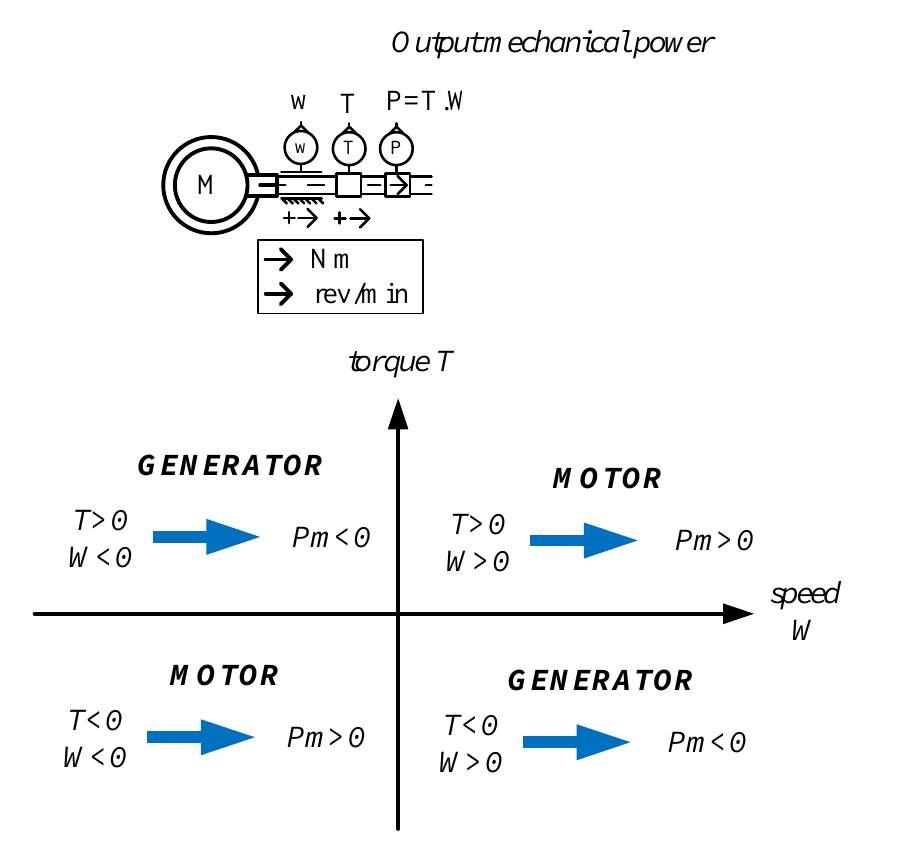
Figure 9. Working principle of the electric motor/generator. Table 1. Setting parameter of the proposed system.